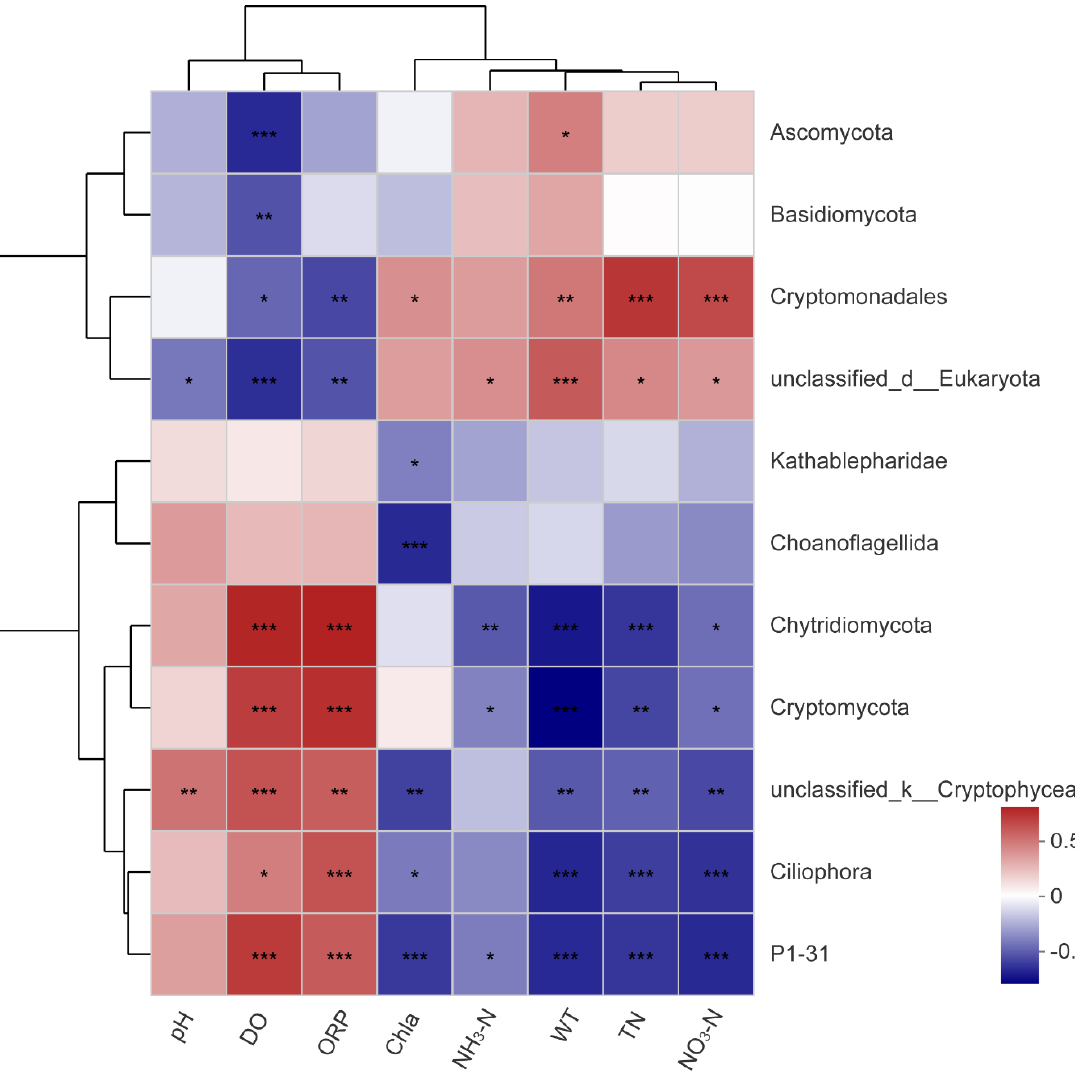
Figure 8. Heatmap of Spearman correlation coefficients between planktonic eukaryotic taxa and environmental factors (* indicates significant correlation at the 0.05 level; ** indicates significant correlation at the 0.01 level; *** indicates significant correlation at the 0.001 level).